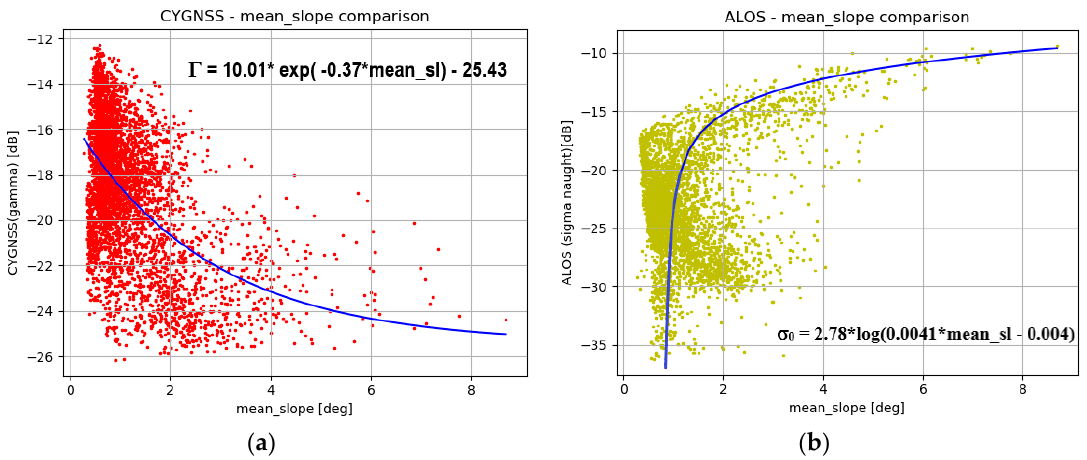
Figure 7. Plot of roughness mean slope and satellite data: ( a ) CYGNSS reflectivity, ( b ) ALOS-2 backscattering coefficient.